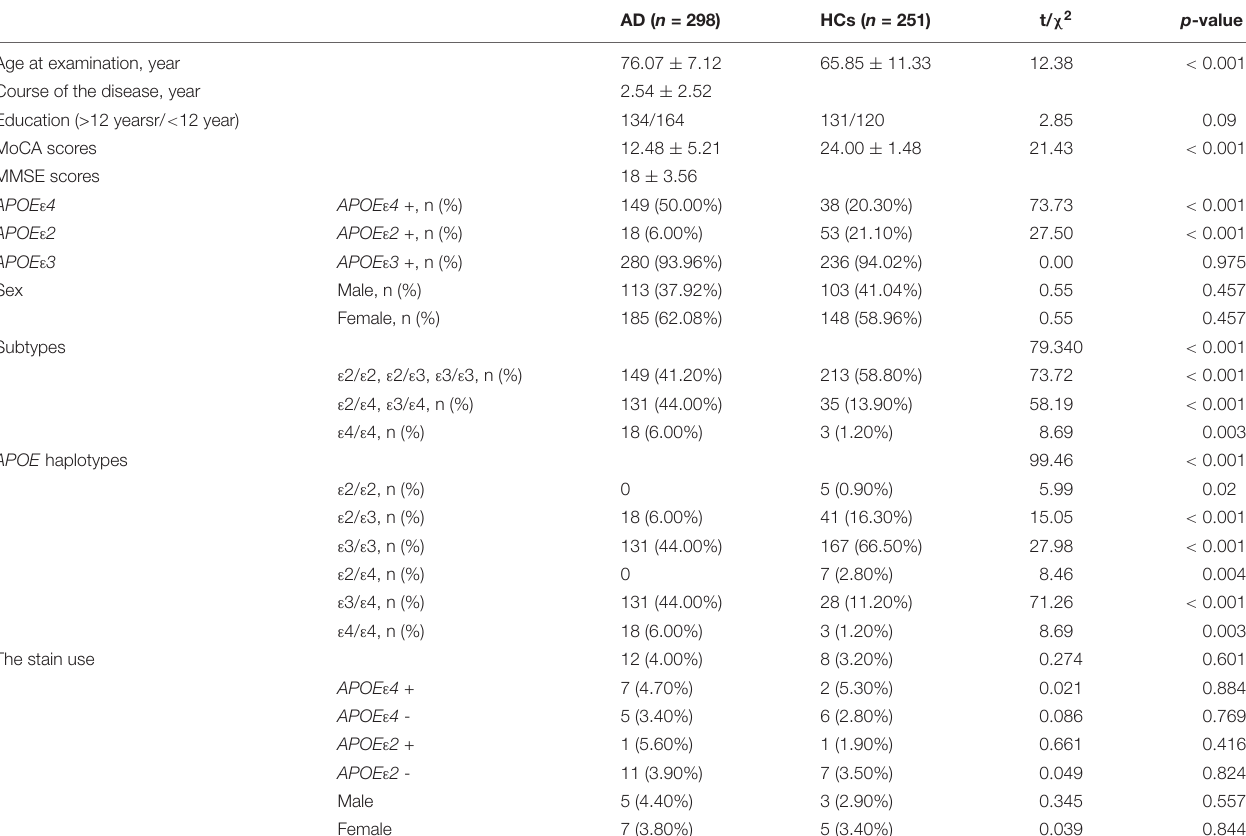
TABLE 1 | APOE gene and sex distribution in AD group and HCs group (mean ± standard